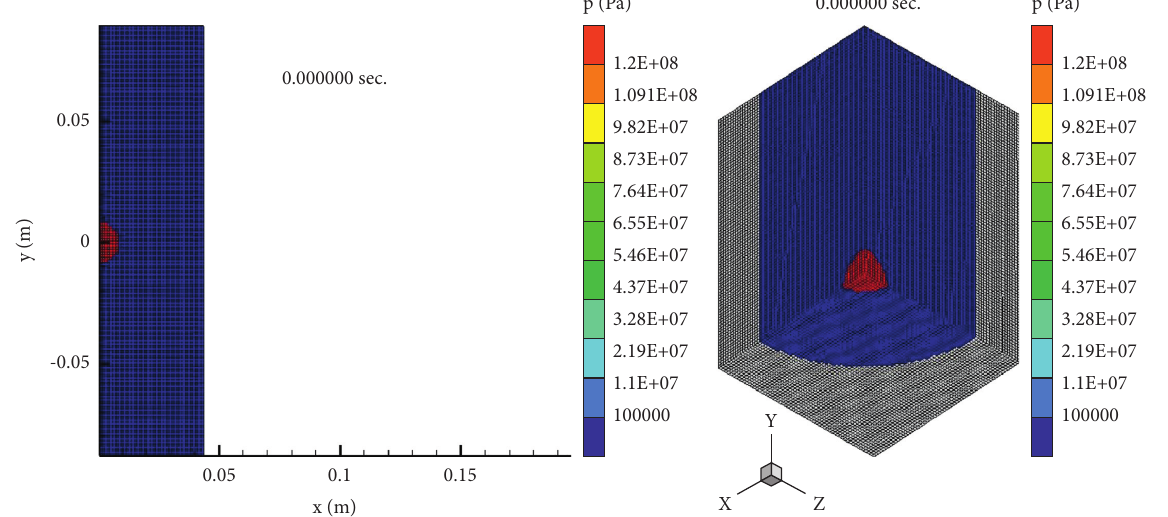
Figure 23: Initial conditions of Case 7 (left: 2D simulation; right: 3D simulation).